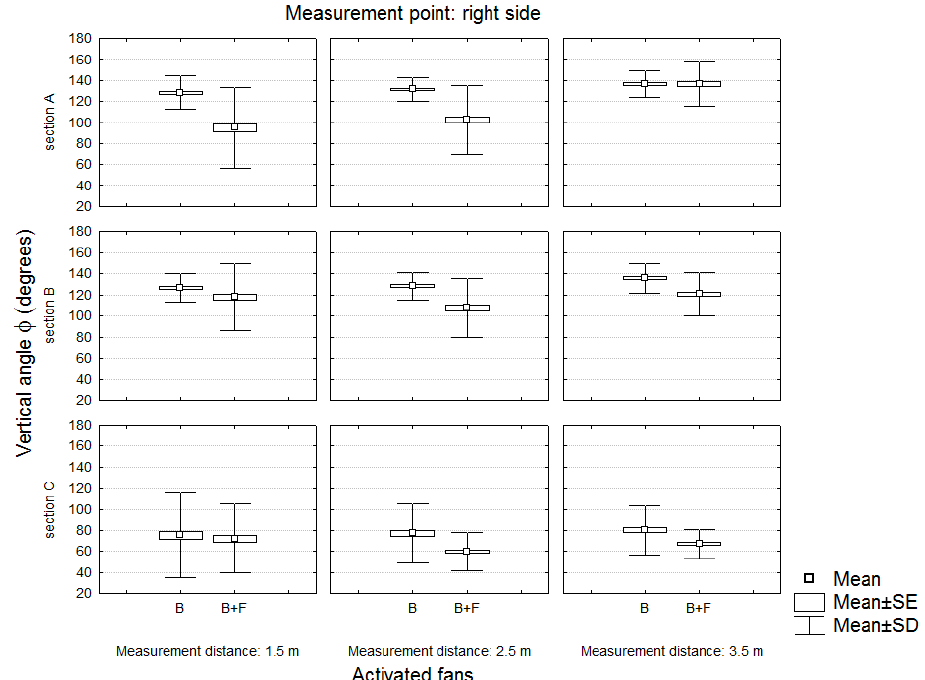
Figure 12. Vertical angle of the velocity vector according to the number of active fans and the measurement section. Values of the right working side.